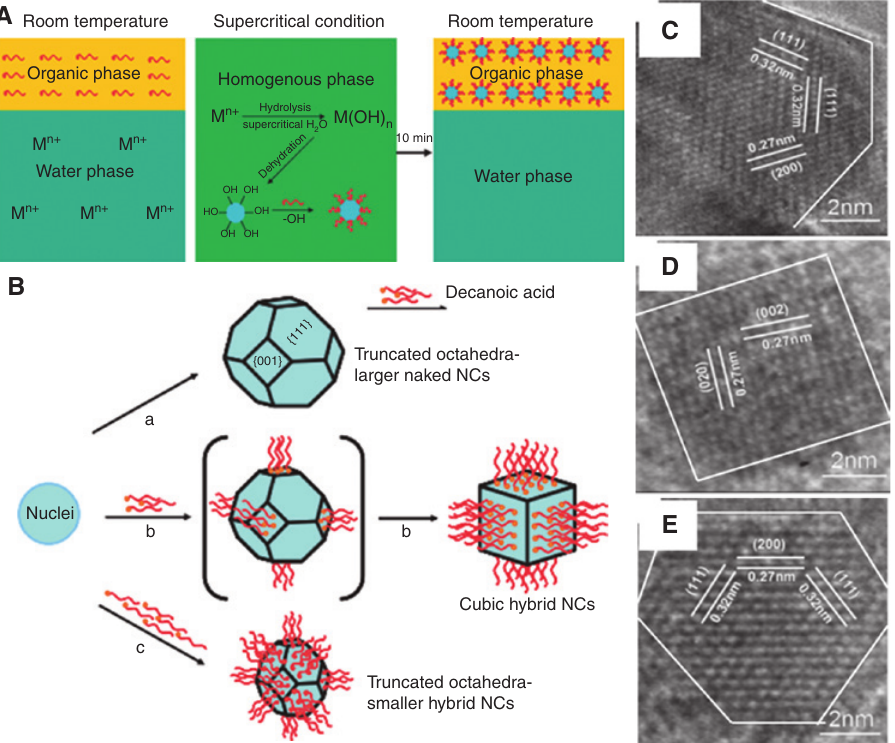
Figure 17: Batch supercritical hydrothermal synthesis of oxide-based hybrid nanostructures: (A) nanocrystals synthesis strategy; (B) growth mechanism influenced by organic surfactant; (C) CeO NCs in the absence of surfactant; (D) cubic CeO NCs when the surfactant 2 2 concentration is low; and (E) hybrid CeO NCs with a high surfactant concentration. Reprinted with permission from Zhang J, Ohara S, 2 Umetsu M, Naka T, Hatakeyama Y, Adschiri T, Adv. Mater. 2007, 19, 203–206 [94], Copyright 2007 J.